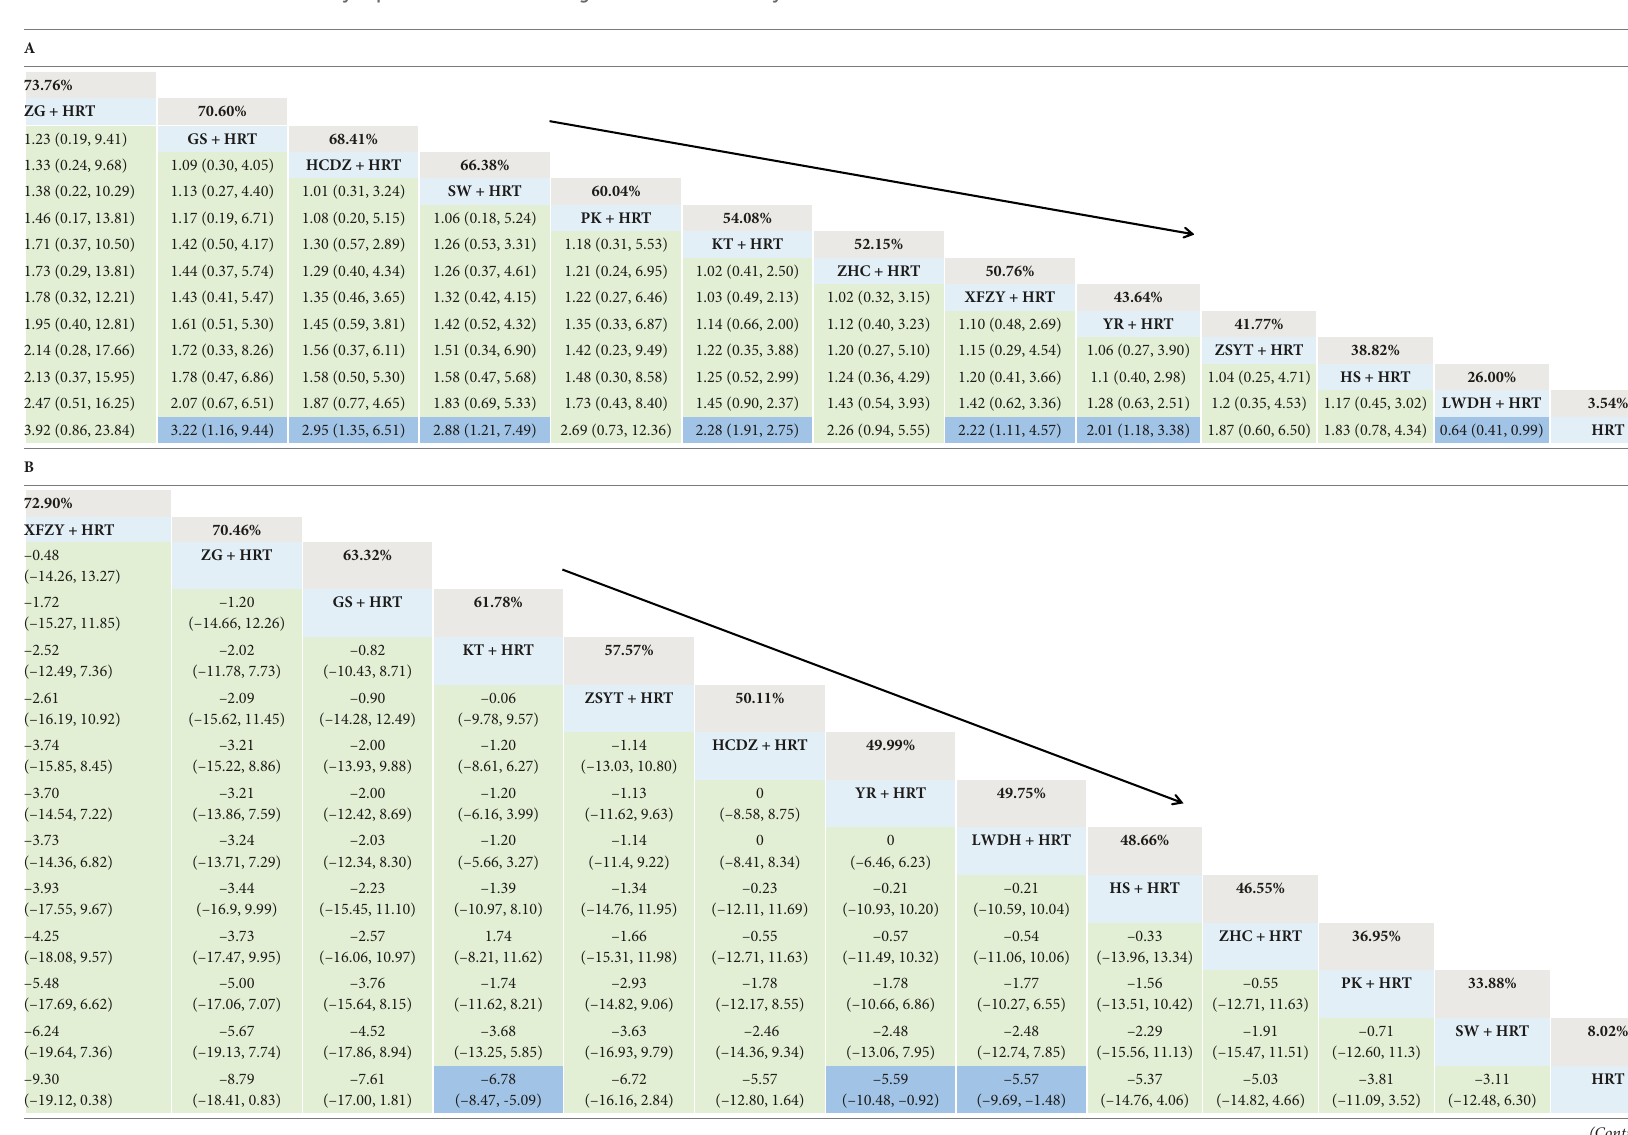
TABLE 1 Relative effect sizes of efficacy at post-treatment according to network